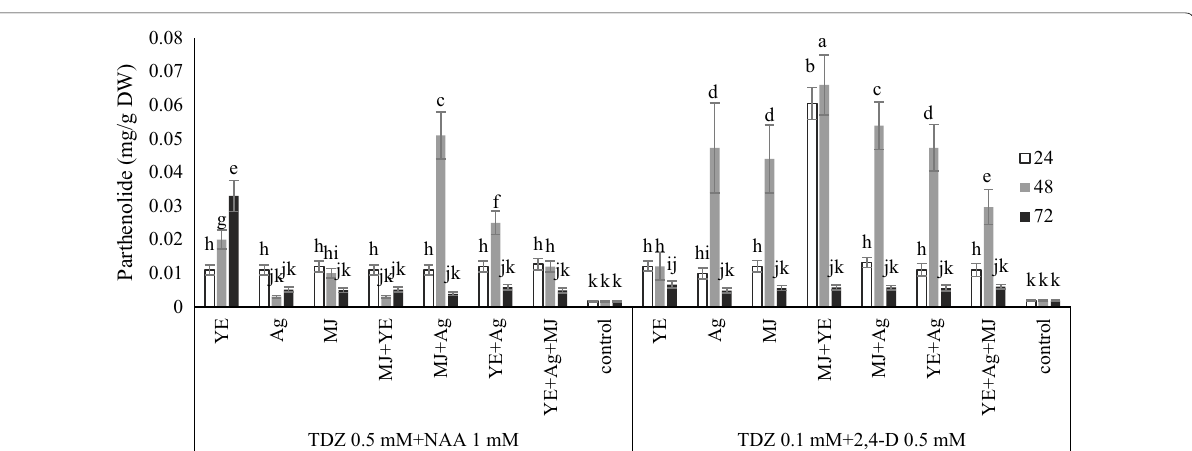
Fig. 4 Effect of hormonal combination, elicitors on parthenolide production in feverfew cell suspension culture after 24, 48 and 72 h of elicitor application. Means with different letters were significantly different according to the LSD